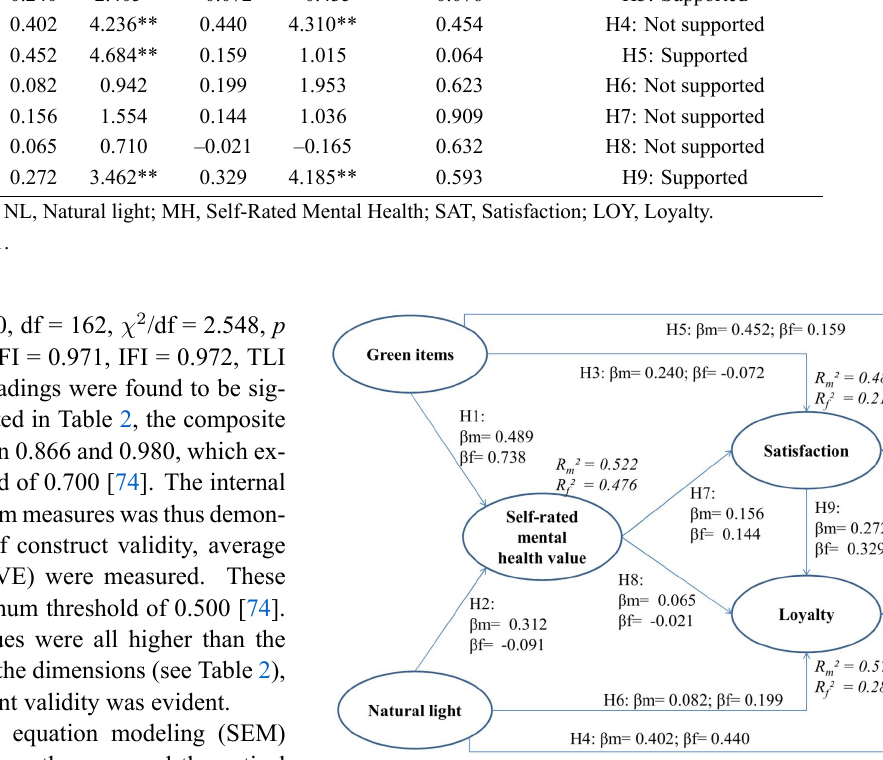
Fig. 2. The results of the structural